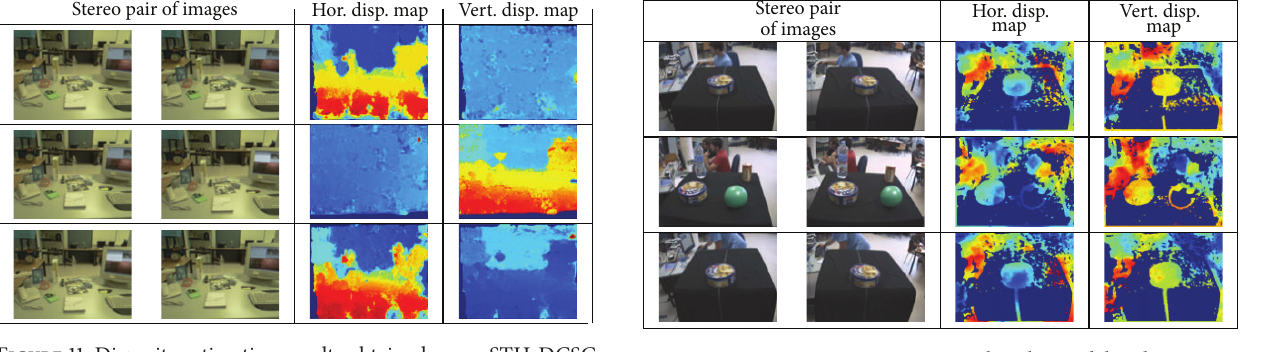
Figure 13: Disparity estimation results obtained by the PBBDE approach on the images acquired by a RoboSoft TO40 setup such that the fixation point is at the cake box and the disparity maps are coded from red (positive values of disparity) to blue (negative